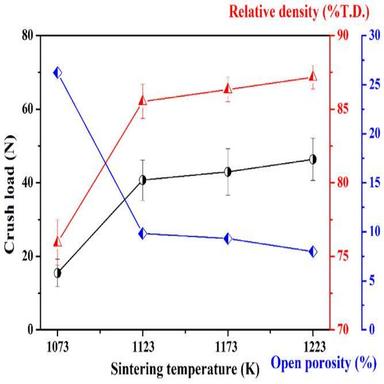
Porosity, relative density and crush load of the pebbles sintered at different temperatures in air.